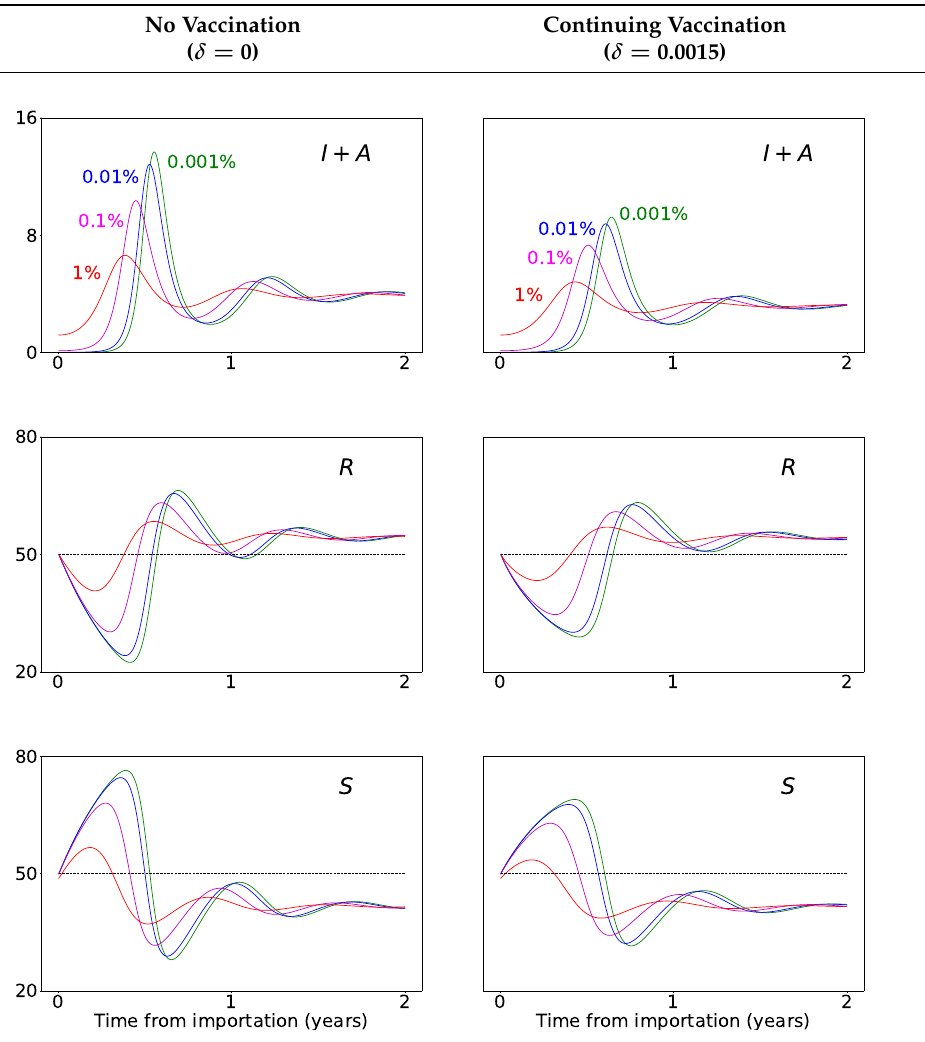
1 = 0.16, α 1 = 0.20 with waning immunity κ = 0.006, for the case of no further vaccination ( δ = 0, left column) and continuing vaccination ( δ = 0.0015, right column). The scales in the y-axis represent percentages of the total population. The black dashed horizontal line represents the 50% initial immunity